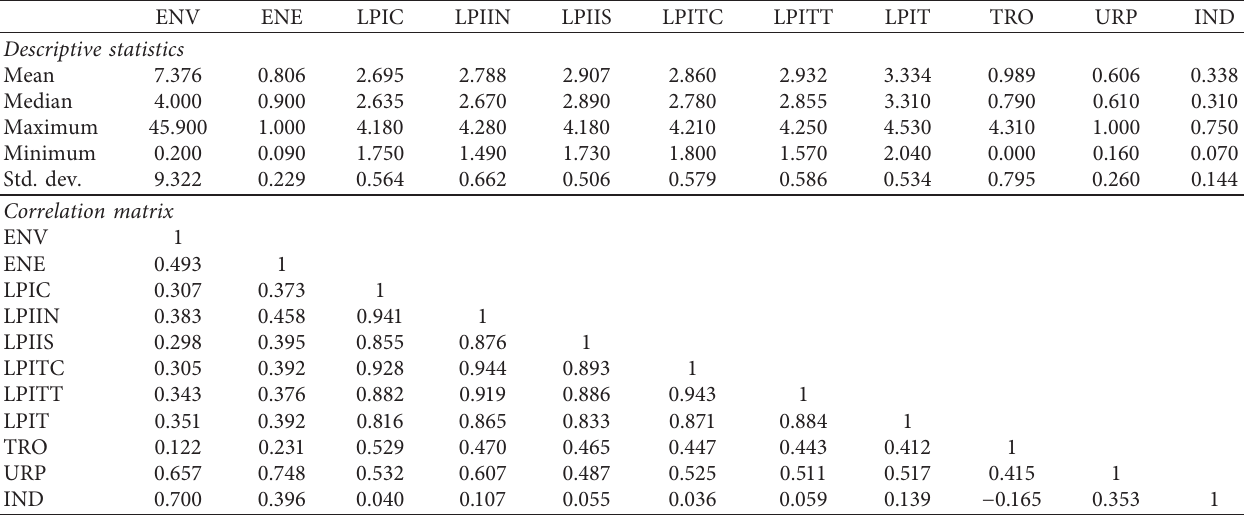
Table 2: Descriptive statistics and correlation matrices, N �